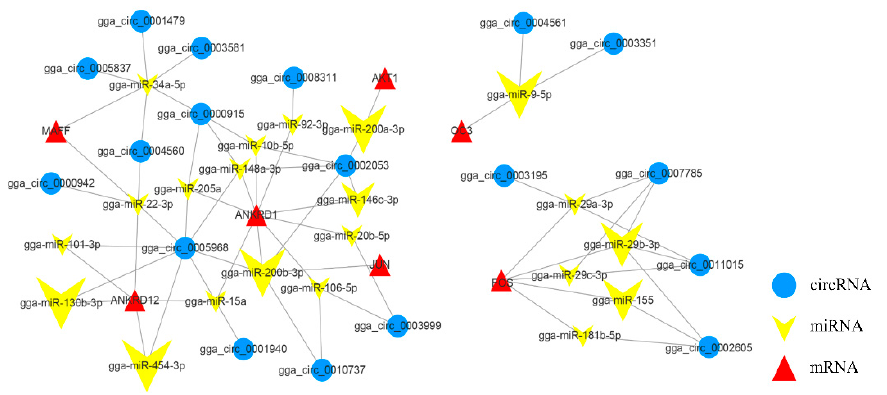
Figure 6. CircRNA-miRNA-gene interaction network related to skeletal muscle development. The circle, inverted arrows, and triangles represent circRNAs, miRNAs, and mRNAs, respectively.